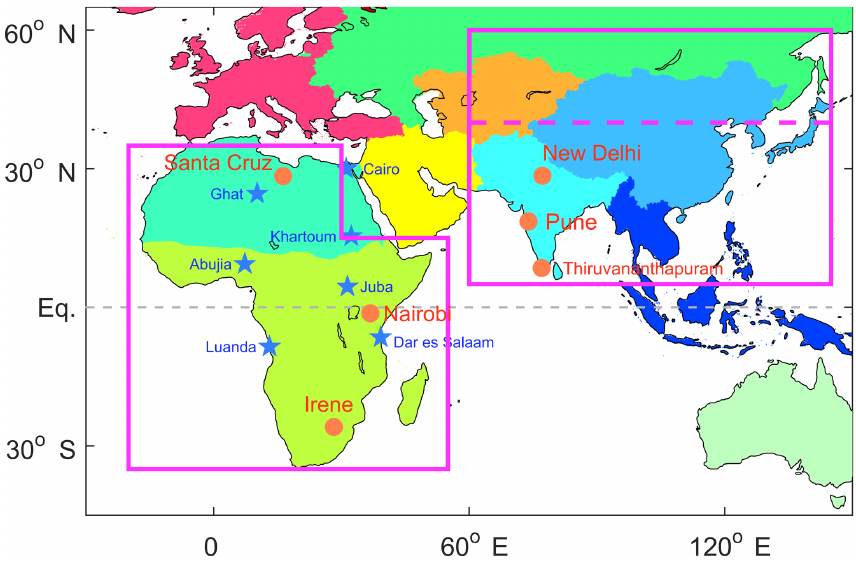
Figure 1. Domains of the source region, Africa, and the receptor region, Asia (areas within the solid purple lines). The area south of the pink dashed line at 40 ◦ N in Asia is used for calculating the regional mean of Asia for Figs. 6, 7, and 15. The brown dots indicate the locations of the ozonesonde sites where the ozone measurements are compared with the GEOS-Chem simulations. The seven blue stars indicate the sites where forward trajectory simulations are originated. The color-filled continents stand for the source and receptor regions defined in HTAP Phase 2